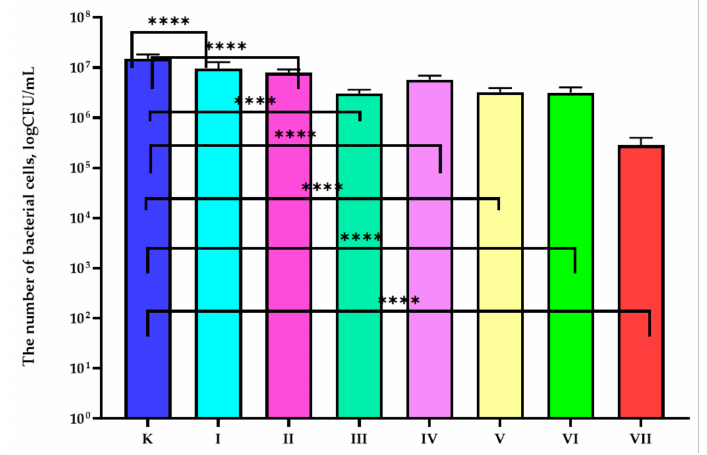
Figure 2. The influence of coated, active films on E . coli growth. One-way ANOVA test: ****— p < 0.0001.